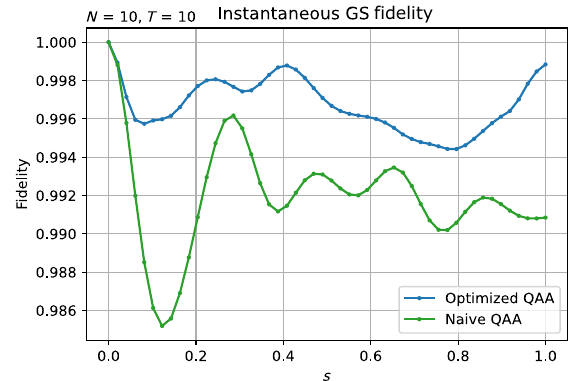
FIG. 14. In this instance, albeit for N = 10, we see near per- fect ground-state preparation for T = 10 without increasing the total time budget. Even though the instantaneous ground-state fidelity with H ( s ) along the adiabatic path is smaller, the final ground-state fidelity is 0.999.